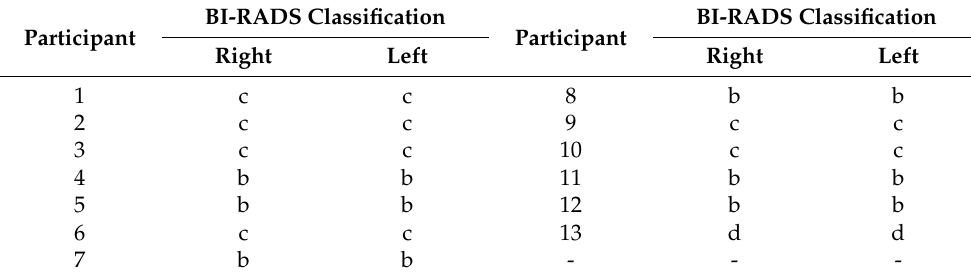
Figure 2. Bioimpedance measurement system: ( a ) designed latex cups within brassiere; ( b ) measur- ing participant’s breast bioimpedance. Table 2. PBD evaluated by mammary radiology specialist. Table 2. PBD evaluated by mammary radiology specialist.